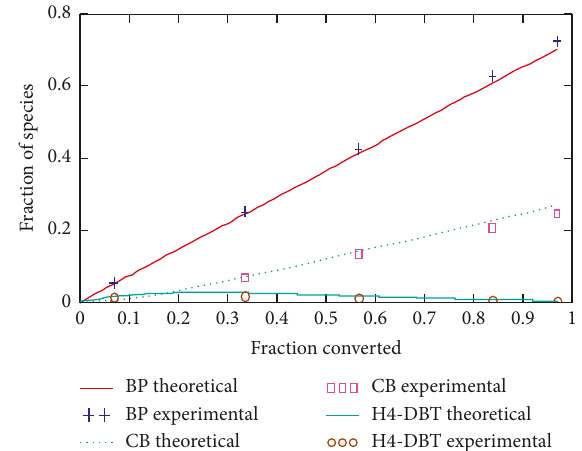
Figure 4: Transformation of dibenzothiophene over the C-ATS-I catalyst in the presence of H 2 S.